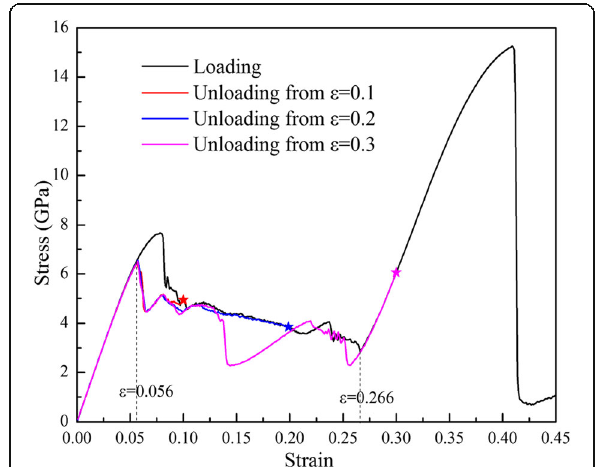
Fig. 8 Loading and unloading σ - ε curves tension along [001] from different